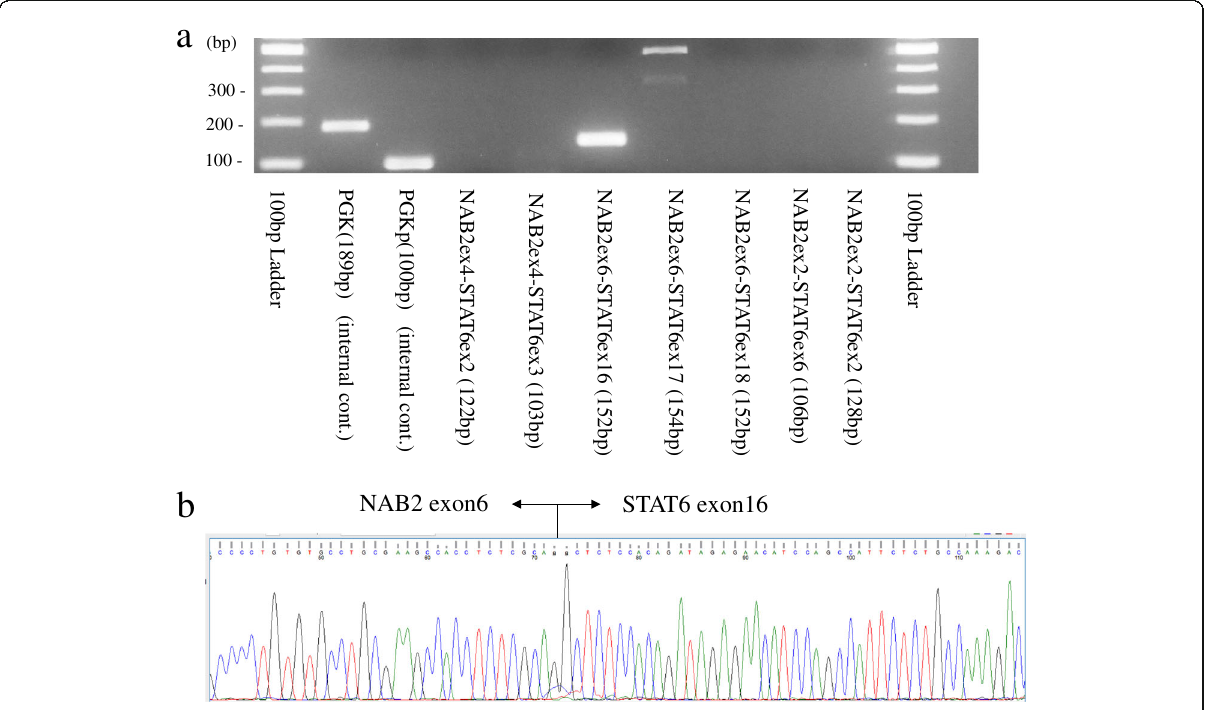
Fig. 4 NAB2 – STAT6 fusion gene in the SFT identified by RT-PCR and sequencing. Gel electrophoresis of PCR products reveals the various NAB2 – STAT6 fusion genes with heterogeneous exon compositions in the tumor, which were identified using seven primer pairs ( a ). Direct sequencing shows the junction breakpoint in a stretch of NAB2 intronic sequence between the 3 ′ -end of the NAB2 exon 6 and the 5 ′ - end of the STAT6 exon 16 ( b